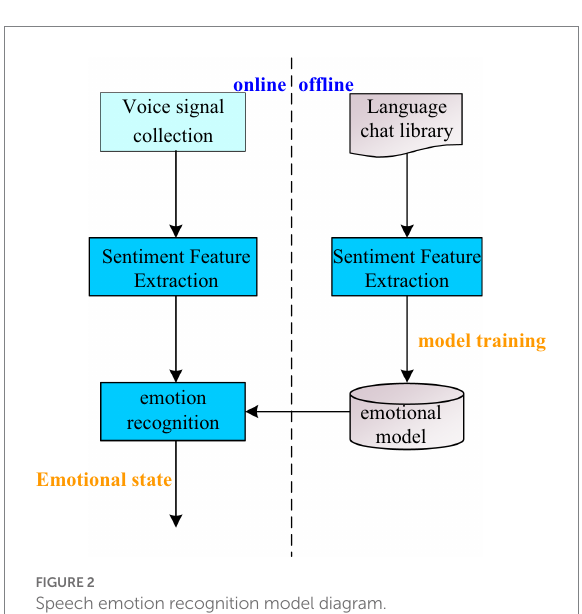
FIGURE 2 Speech emotion recognition model